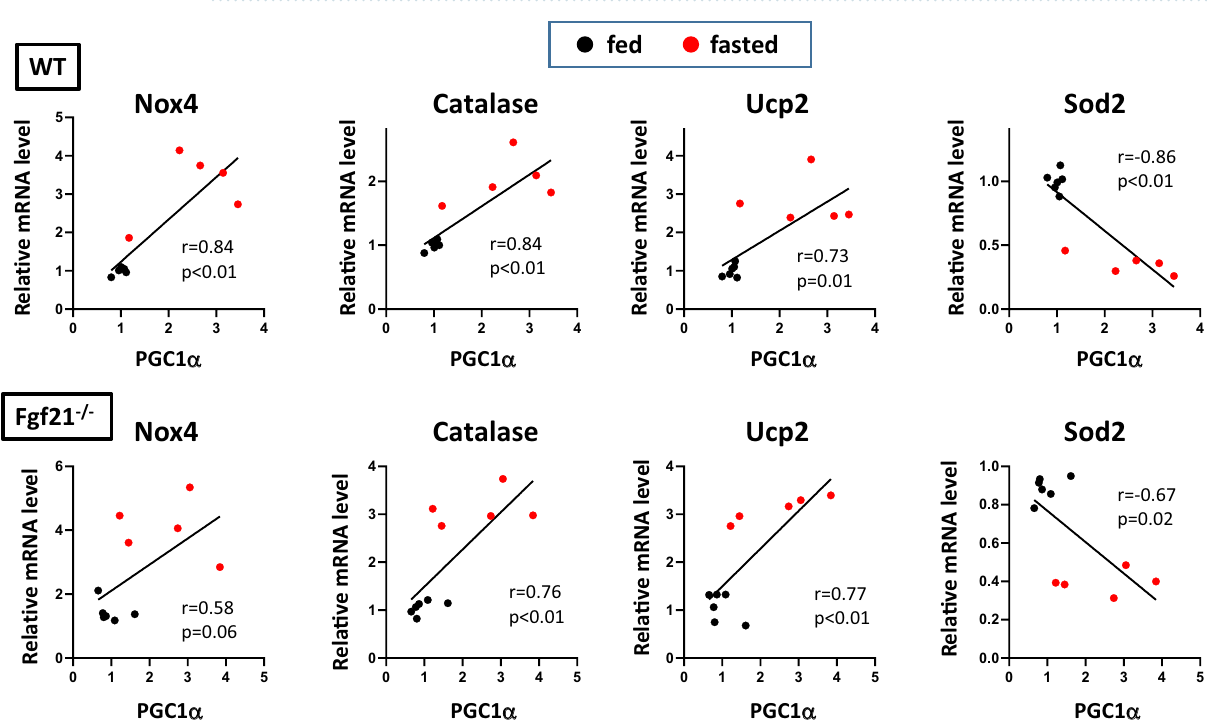
Figure 7. Correlations of the oxidative stress response gene expression with PGC1α in Fgf21 −/− mice hearts. Linear gene expression values for Nox4, catalase, Ucp2 and Sod2 are shown in the y -axis in relative fluorescence units, whereas PGC1α expression levels are shown in the x -axis. Pearson’s correlation coefficient and p-value are